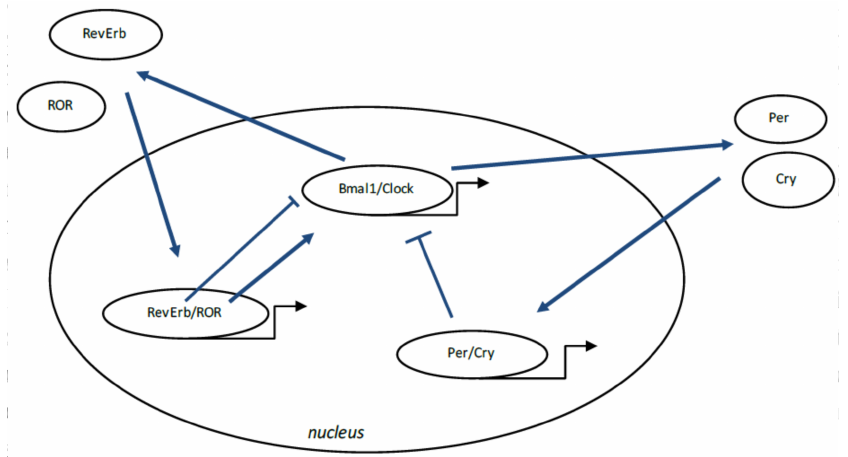
Figure 3. Circadian clock genes process. The clock is considered as a stimulatory loop, with the Bmal1/Clock heterodimer activating the transcription of Period (Per) and Cryptochrome (Cry) genes, and then a negative feedback loop with the Per/Cry heterodimer which translocates to the nucleus and then represses the transcription of the Clock and Bmal1 genes. An additional loop implicates the RORs and Rev Erbs factors with a positive feedback by retinoid-related orphan receptors (ROR) and a negative feedback by Rev Erbs. Arrows: activation; T bar: